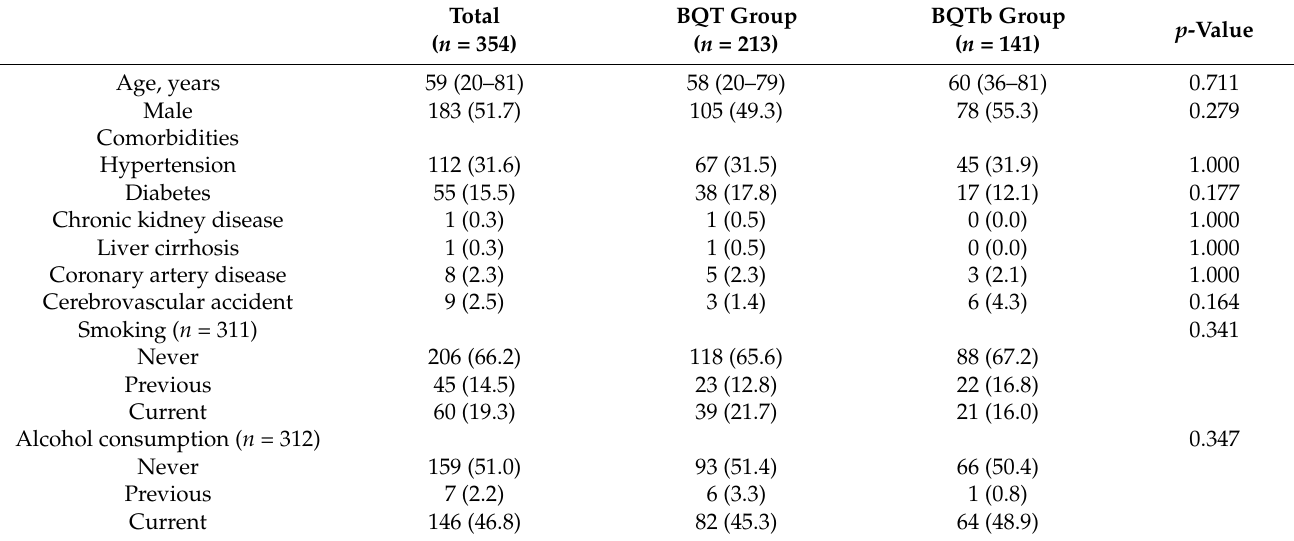
Table 1. Demographic and clinical characteristics of the study population.